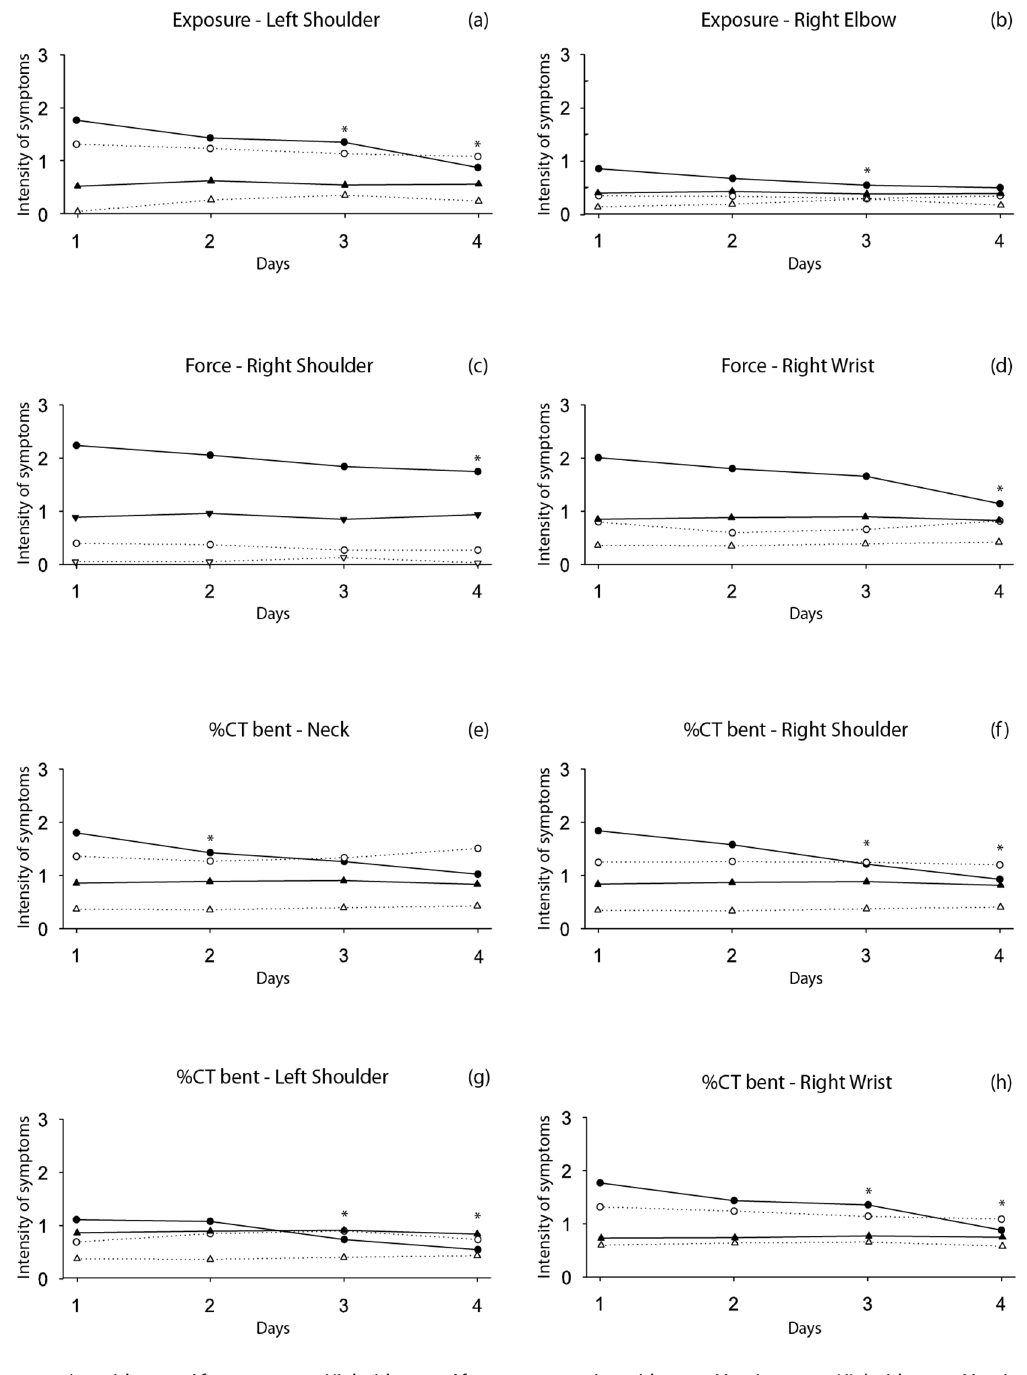
Figure 1. Trajectory of MSP reported at the beginning and the end of the shift during the 4 period of data collection. ( a ) Within-group changes are shown for exposure and left shoulder; ( b ) within-group changes are shown for exposure and right elbow; ( c ) within-group changes are shown for force and right shoulder; ( d ) within-group changes are shown for force and right wrist; ( e ) within-group changes are shown for %CT bent and neck; ( f ) within-group changes are shown for %CT bent and right shoulder; ( g ) within-group changes are shown for %CT bent and left shoulder; ( h ) within-group changes are shown for %CT bent and right wrist. * Within-group changes for the afternoon group significant at p <